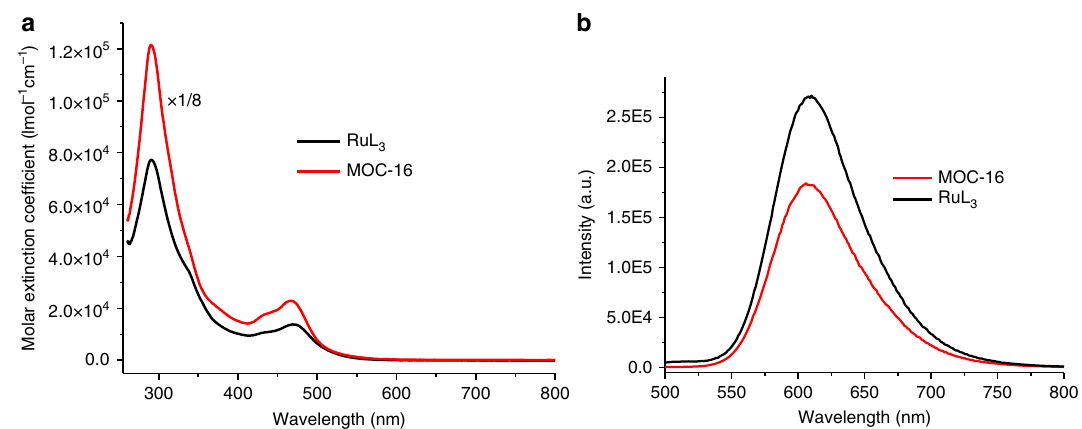
Figure 4 | UV–VIS absorption and emission spectra of RuL 3 metalloligand and MOC-16 in DMSO. ( a ) Electronic absorption spectra ( C RuL3 ¼ 8.0 (cid:3) 10 (cid:2) 6 and C MOC-16 ¼ 1.0 (cid:3) 10 (cid:2) 6 M for equivalent RuL 3 ). ( b ) Emission spectra (C RuL3 ¼ 1.76 (cid:3) 10 (cid:2) 4 and C MOC (cid:2) 16 ¼ 1.32 (cid:3) 10 (cid:2) 5 M for equal absorbance at excitation wavelength 466nm).